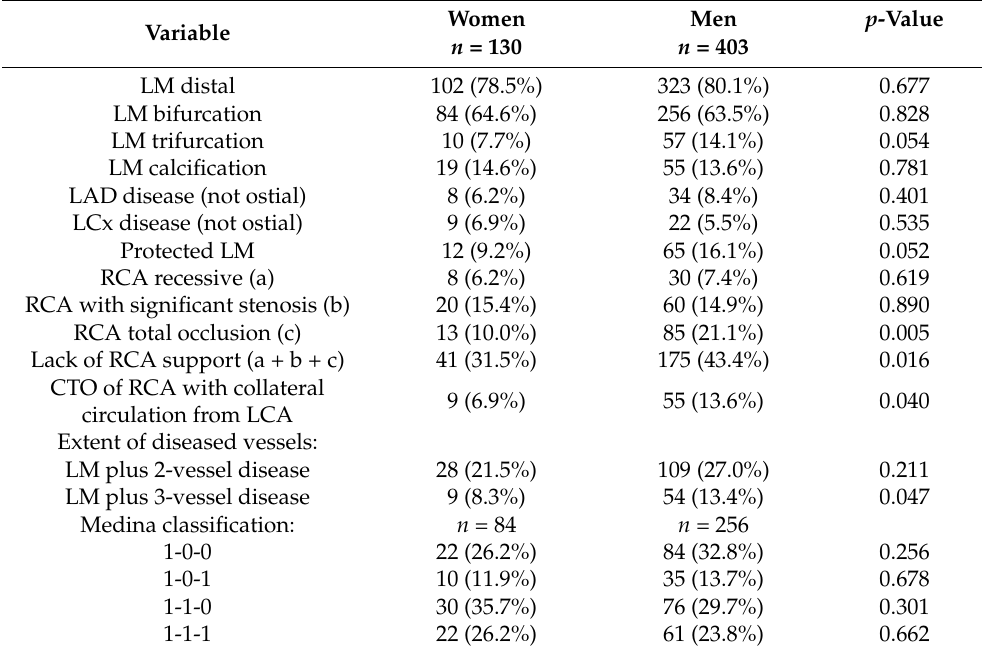
Table 2. Coronary artery disease characteristics.